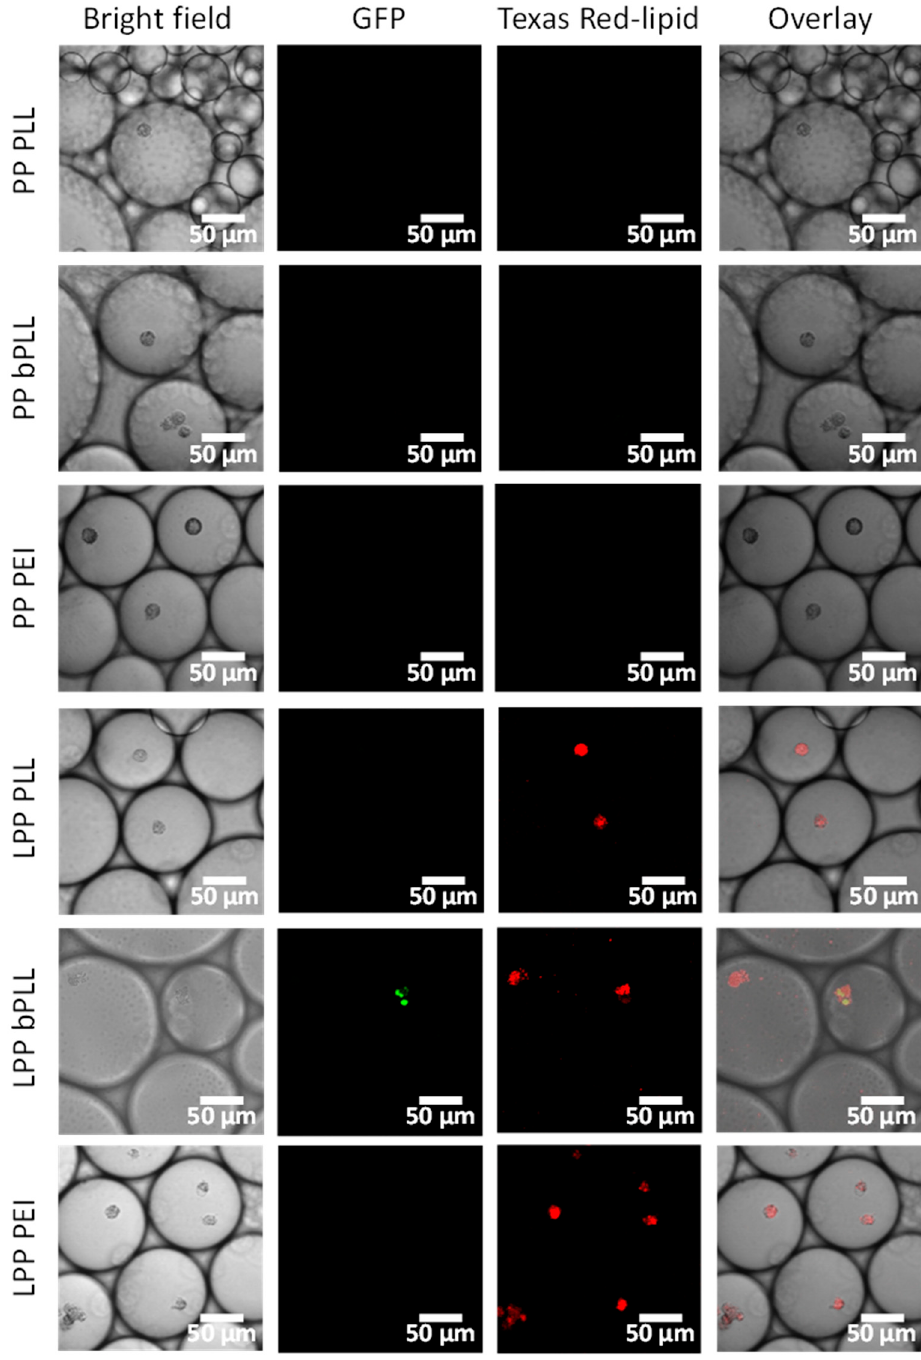
Figure 7. Confocal microscopy images of A549 cells in microdroplet-encapsulated cell culture 3 d after incubation with PPs and LPPs. The figure shows, from left to right, for each treatment: bright-field image, GFP fluorescence (green) for effective transfection, Texas Red lipid fluorescence (red) for successful internalization and overlay of the three previous images.